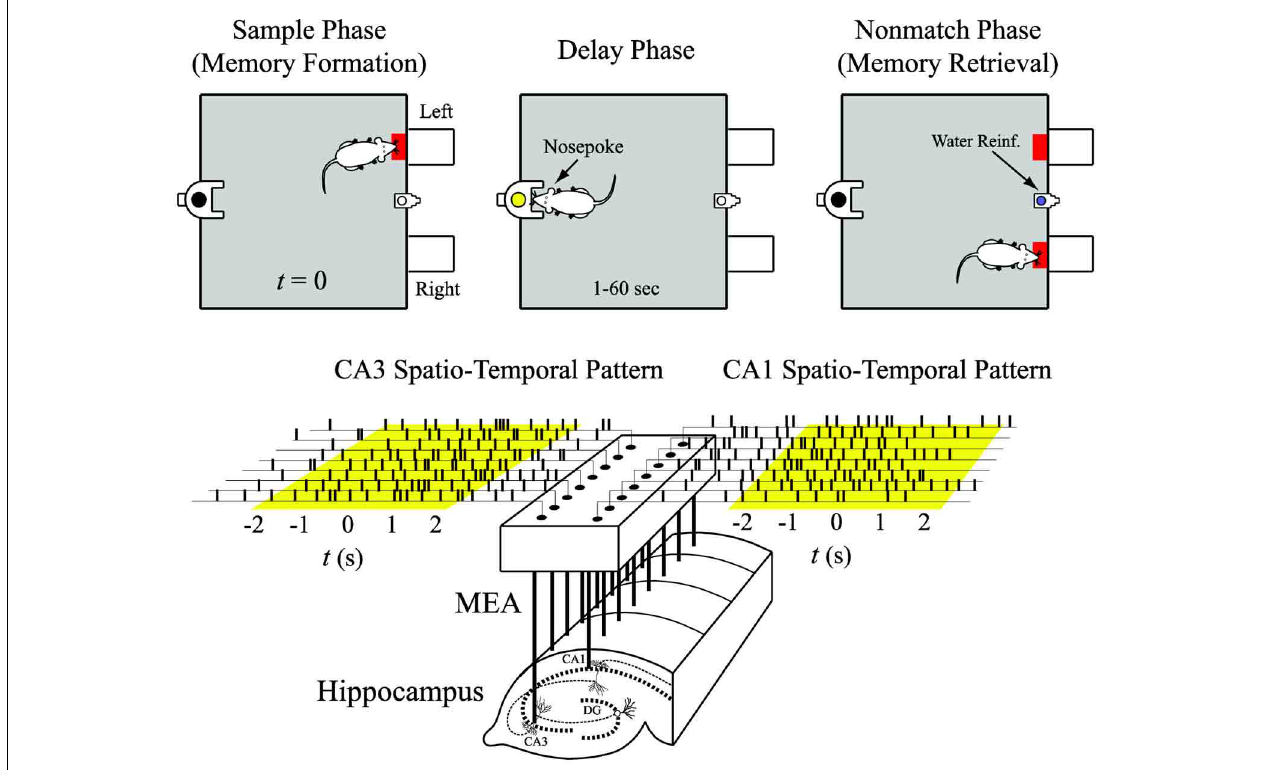
FIGURE 3 | Input (CA3) and output (CA1) spatio-temporal patterns of spikes recorded with a multi-electrode array (MEA) during the sample phase of the delayed-non-match-to-sample (DNMS) task.